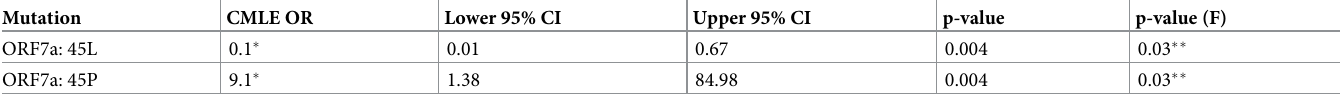
Table 10. Logistic regression analysis of viral ORF7a:P45L mutation and disease severity.